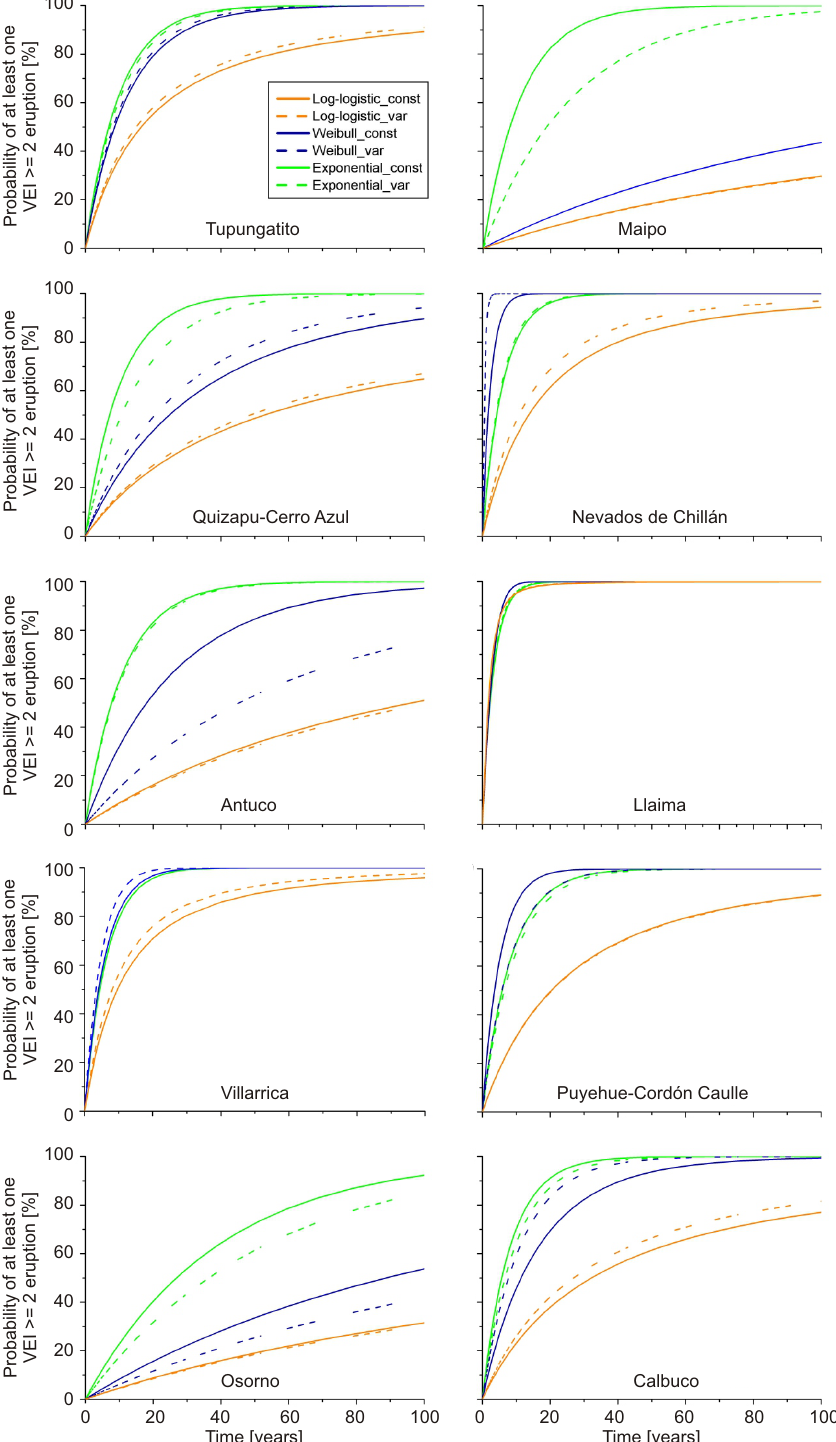
Fig. 6. Statistically predicted probability for at least one eruption of strength VEI=2 or larger occurring in the given time, for each volcano. Colours and line types are as in Fig.